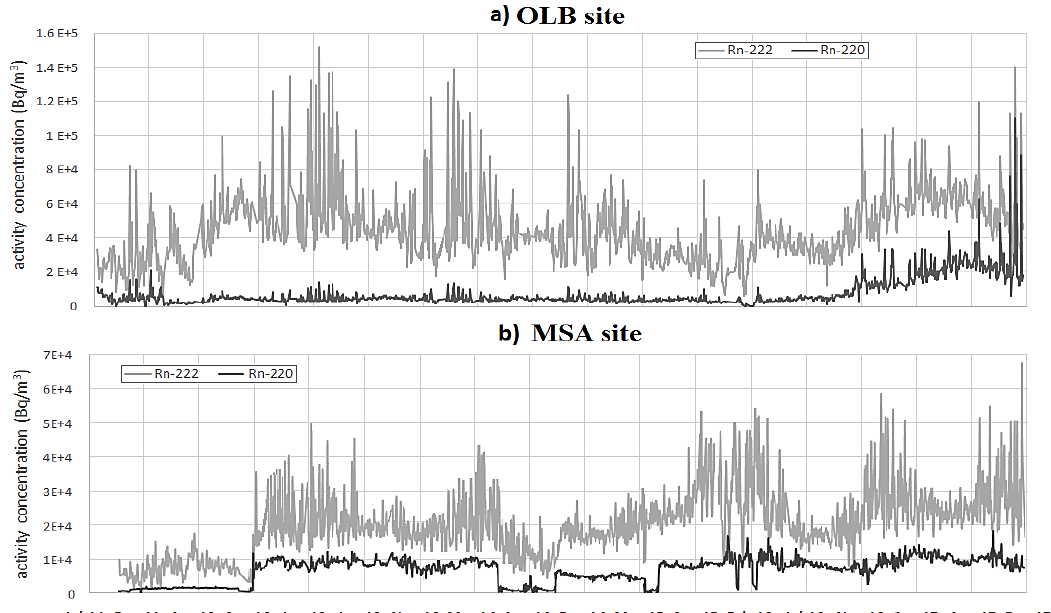
Figure 2. Thoron ( 220 Rn) and radon ( 222 Rn) activity concentration time series recorded at OLB ( a ) and MSA ( b ) sites, from 1 July 2011 up to 31 December 2017. The signals were corrected for the meteorological influences with the MLR method. Lack of data was filled with the SCRE technique. The steep jumps in thoron signal at MSA mean unexpected failure of the data logging network.